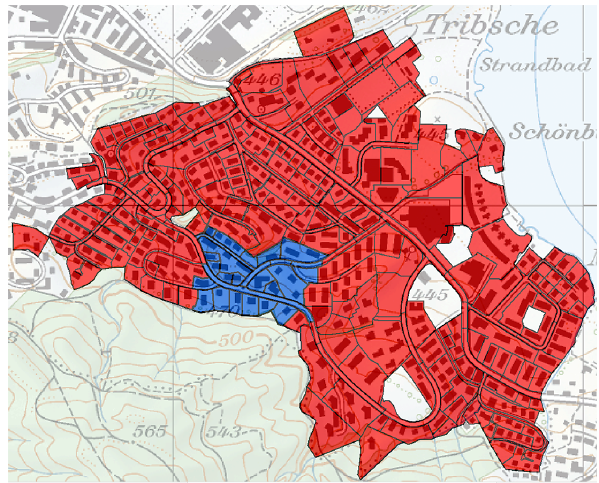
Figure 3. The Wartegg area containing 307 subcatchments (red polygons including blue polygons) overlayed on a topographic map. The performance of classifiers was assessed on a subset depicted in